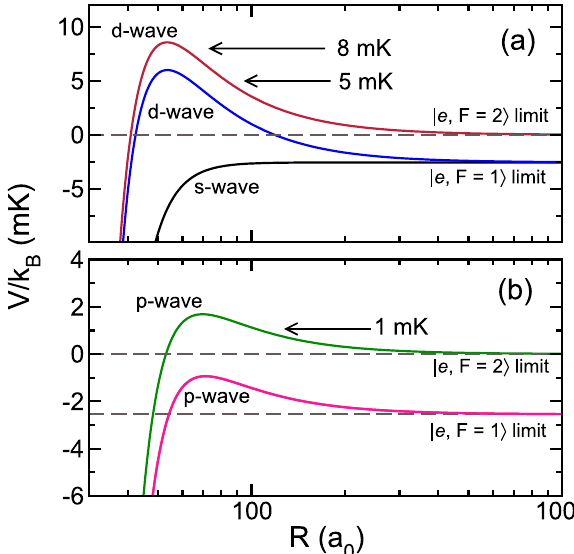
16 OH collision near the 1 88 Sr = + B in mK indicate the locations of